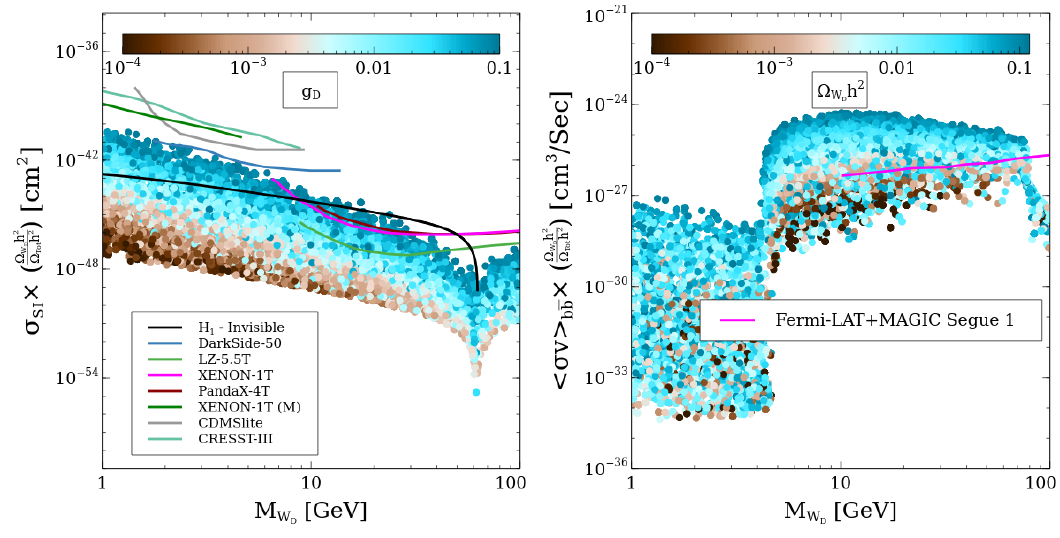
– (Ω Ω ) σ W D / Tot SI D 2 = 0 . 12 is total DM relic density Tot h (left) and D